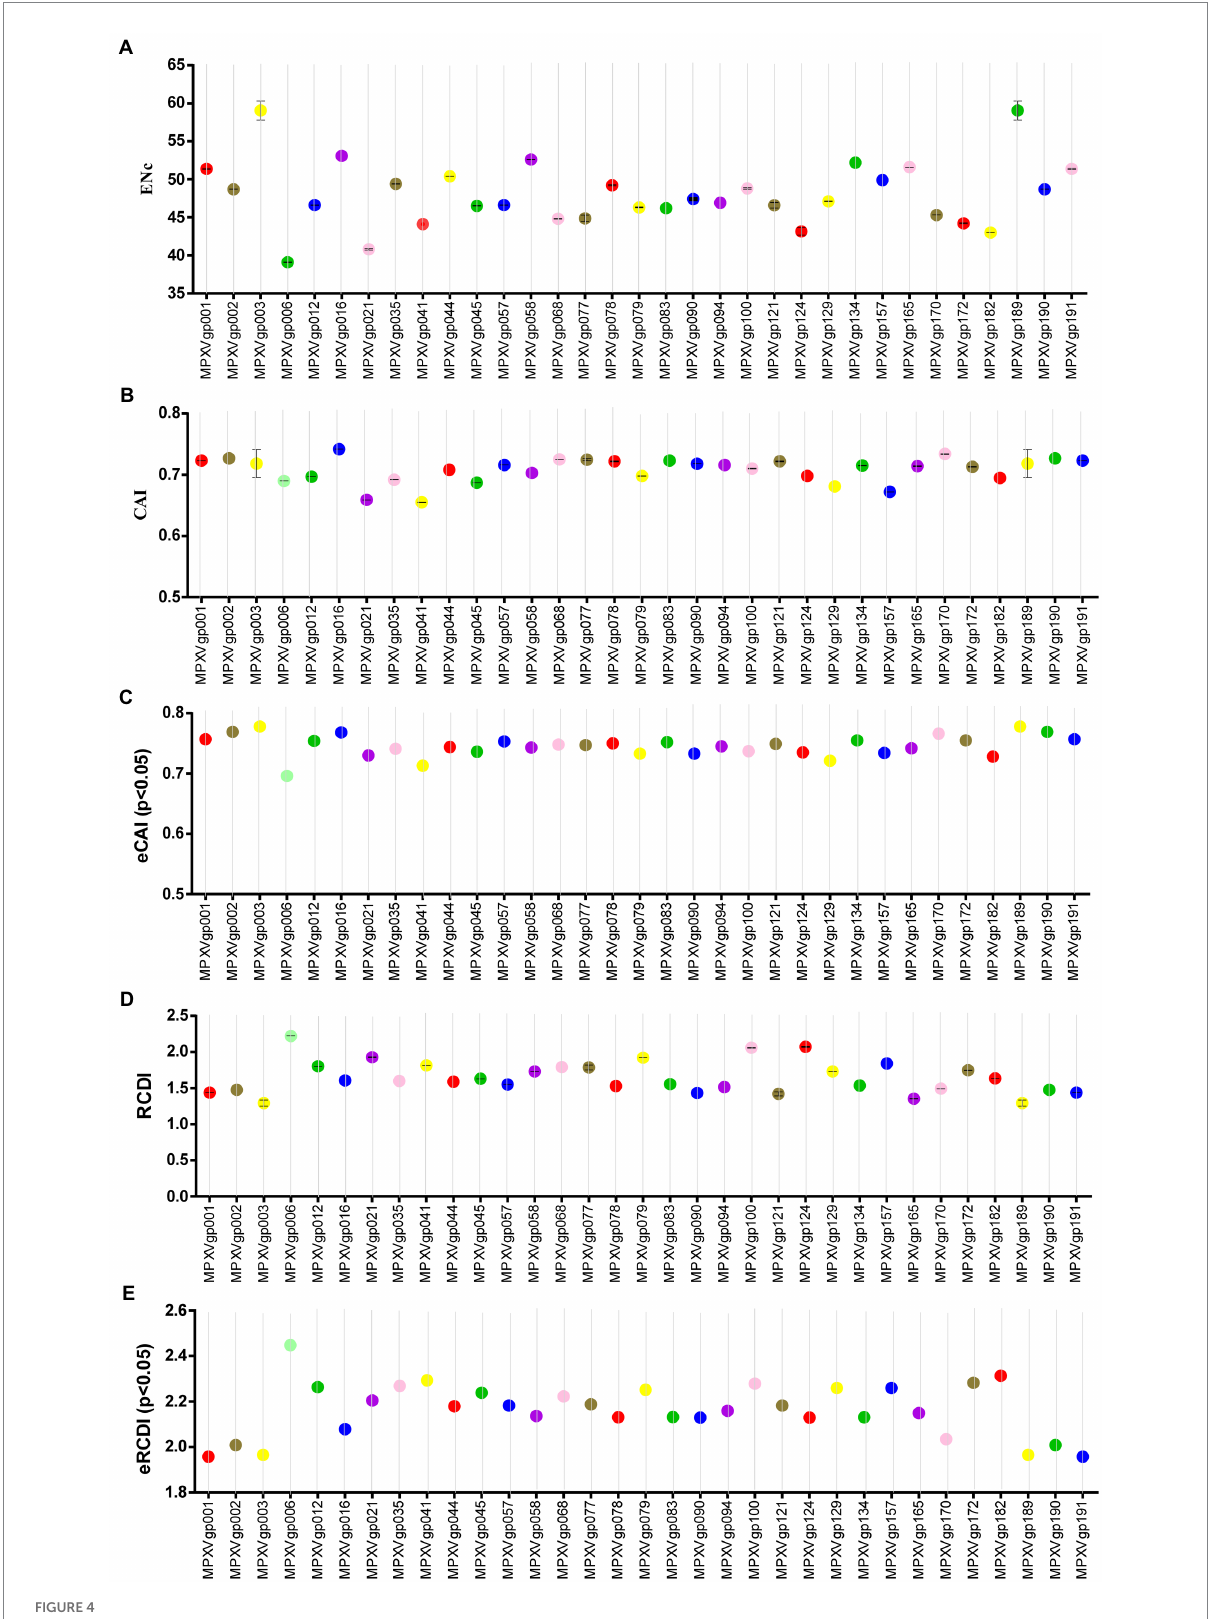
FIGURE 4 Host adaptation indices. (A) Effective Number of Codons (ENc) values for genes displayed mutations in the Clade IIb-B.1 lineages of viruses compared with NC_063383.1/ MT903340.1. More than 1,000 sequences from different lineages in Clade IIb were used, and details are provided